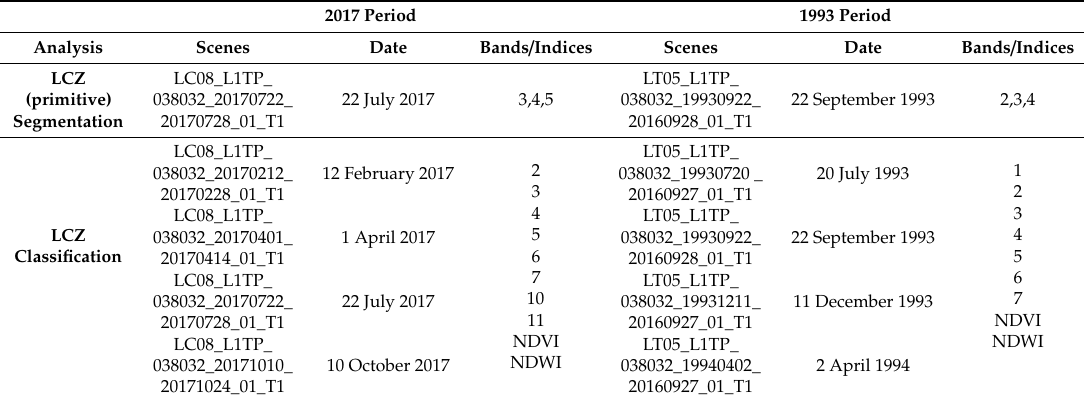
Table 1. Landsat satellite imagery used in object-based segmentation and classification of LCZs.